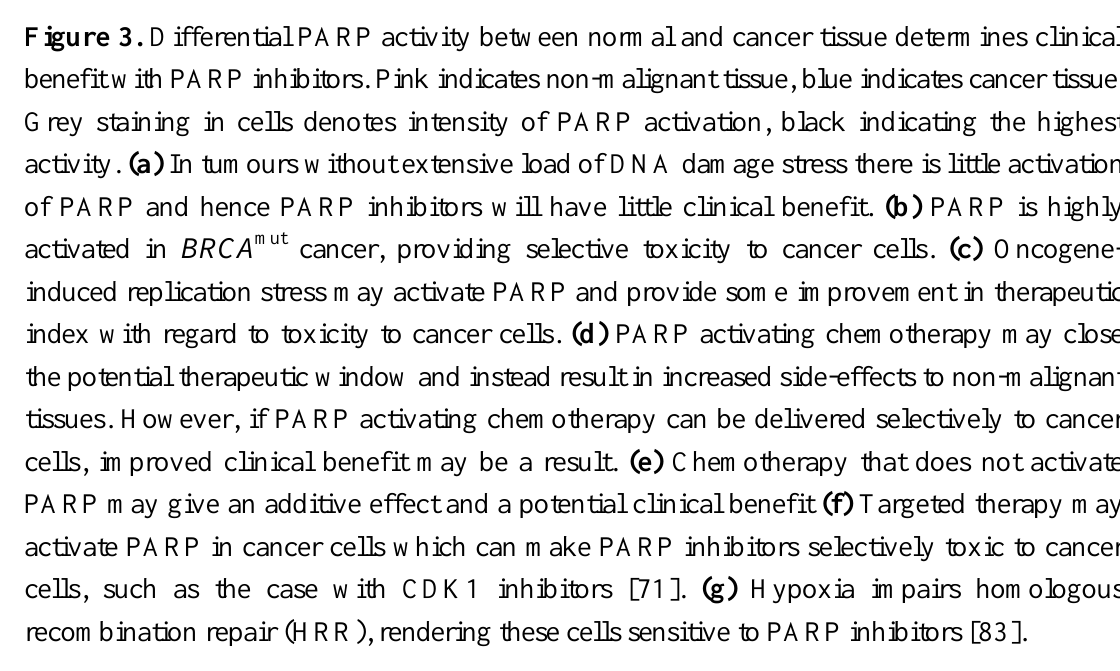
Figure 3. Differential PARP activity between normal and cancer tissue determines clinical benefit with PARP inhibitors. Pink indicates non-malignant tissue, blue indicates cancer tissue. Grey staining in cells denotes intensity of PARP activation, black indicating the highest activity. (a) In tumours without extensive load of DNA damage stress there is little activation of PARP and hence PARP inhibitors will have little clinical benefit. (b) PARP is